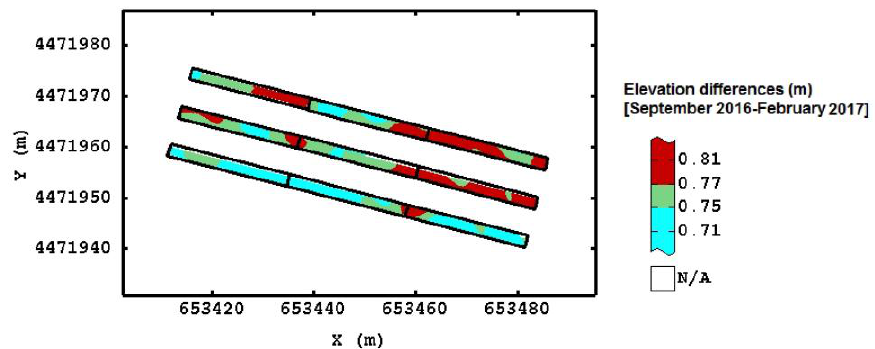
Figure 6. Map of the elevation differences between the estimated elevation in September 2016 and in February 2017.